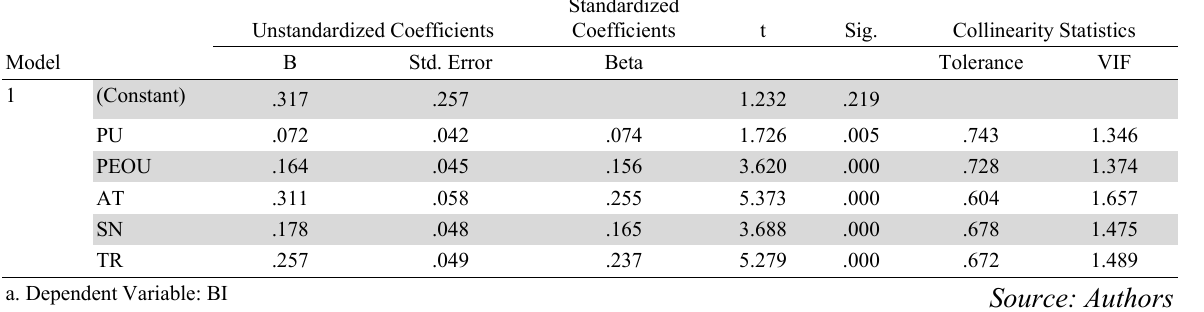
Result of multiple regression of factors impact online shopping